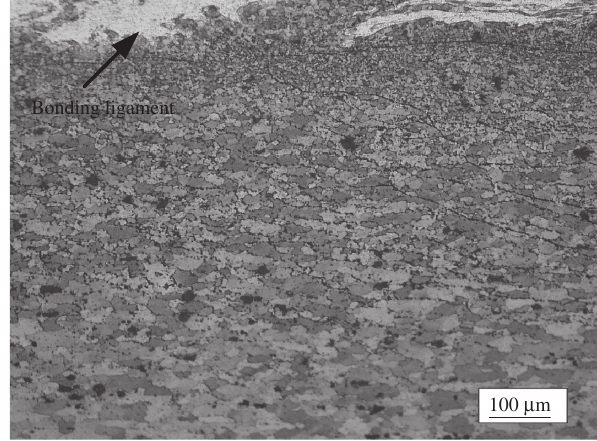
Figure 10: Microstructure variation below the bonding ligament.